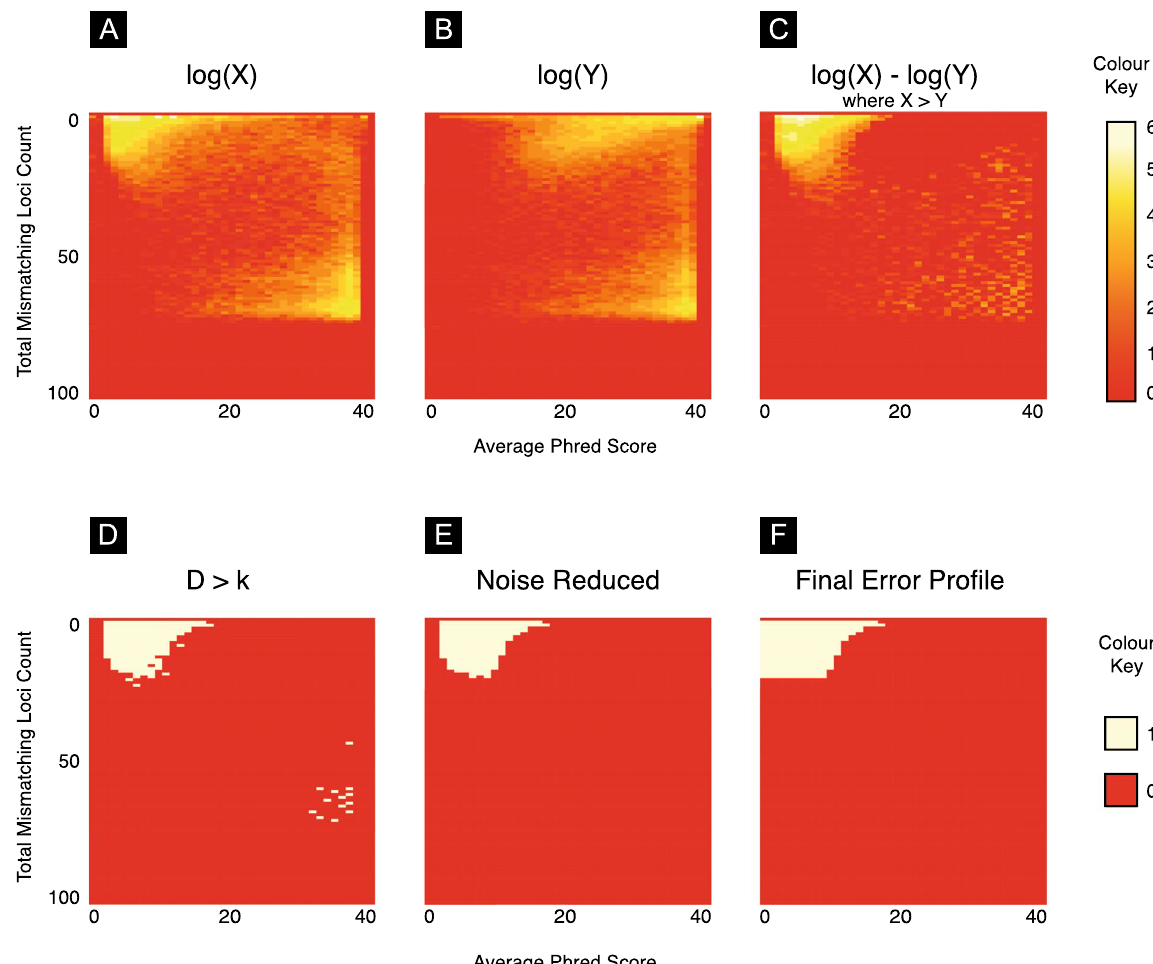
Figure 8. ( A ) A heatmap of the joint distribution of Phred scores a mismatching loci and the number of mismatching loci ( X ). The intensities in the top left corner of the heatmap indicate an association between fewer mismatches and lower phred scores. We observe that the maximum mismatching loci is commonly ~75% of the read length. This effect is caused by non-telomere reads match a the telomere sequence simply by chance ( B ) A heatmap of the joint distribution of random loci in reads and the associated phred score ( Y ). We note that the joint distirubtion of reads in the upper half of the matrix is different to that in X while the lower portion is identical. ( C ) The difference between X and Y . Referred to as D in the text. ( D ) A binary heatmap showing all cells in D that are greater than the threshold k . We note the preponderance of cells in the upper left hand corner of the figure ( E ) We remove noise from the figure using the methods detailed in (Supplementary Algorithm 1) ( F ) We apply a final rule to ensure cells associated with low Phred scores are captured in the error profile (Supplementary Algorithm